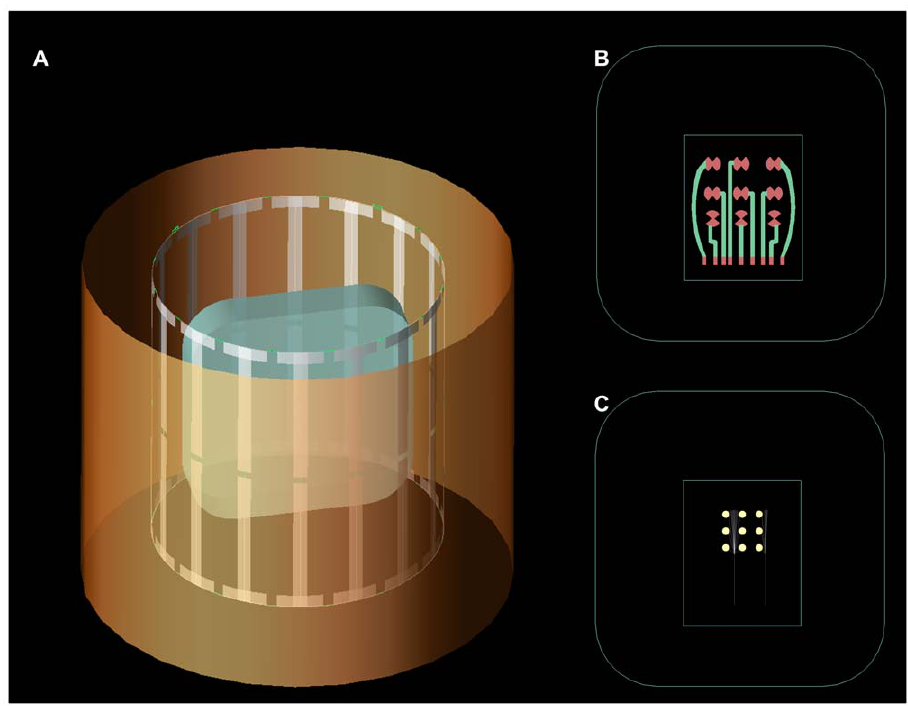
Figure 2. The geometric model used in the electromagnetic simulations. ( A ) The shield, MRI birdcage coil and phantom model used in the Finite Differences Time Domain (FDTD) simulations. Detail model of the (B) PTFOS electrode set and (C) the standard Platinum electrode set.